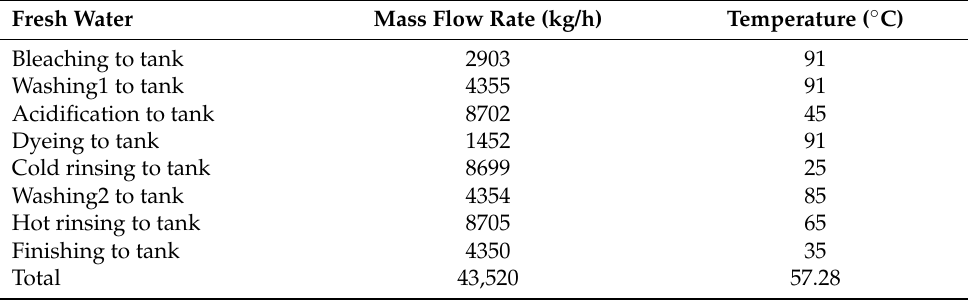
Table 7. Flow rate and temperature of heat-recovered freshwater (Case